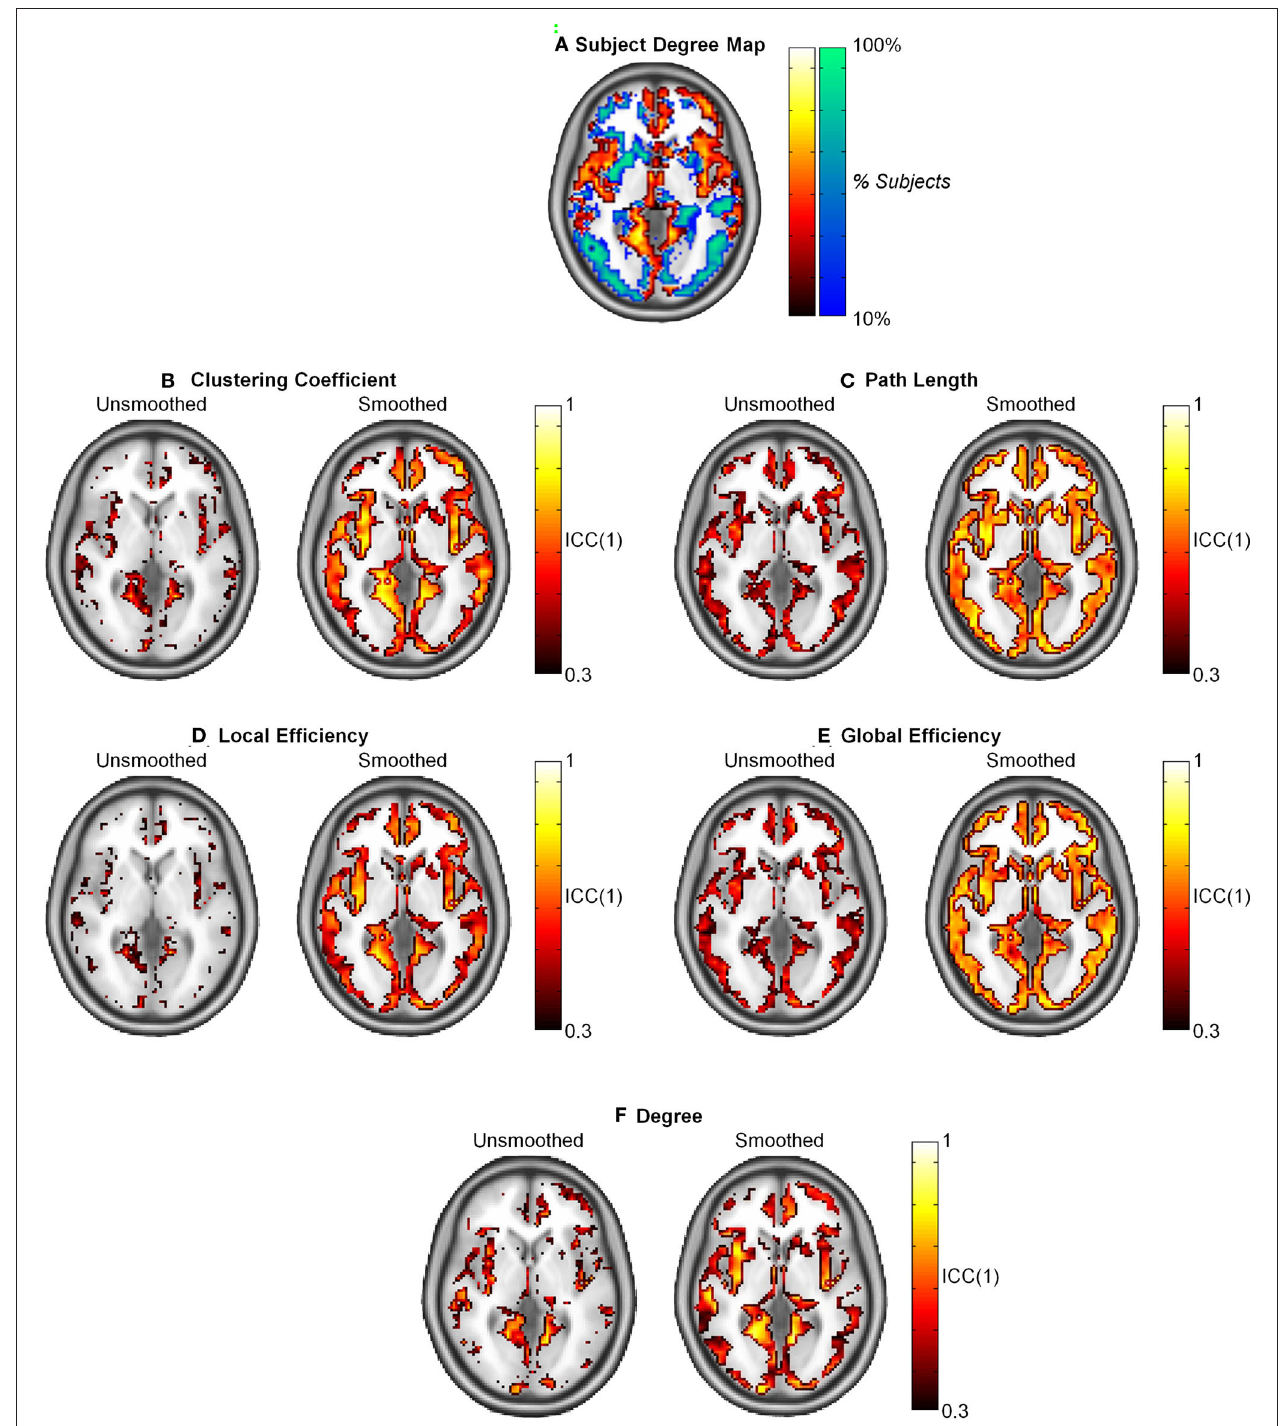
uniform across the brain for L and E (C,e) . Comparing the subject map to glob the ICC(1) maps shows that reproducibility was only high in for C , E , and K loc in regions that consistently exhibited hubs across the study population ( B,D,F ). In all cases, smoothing resulted in higher and more uniform